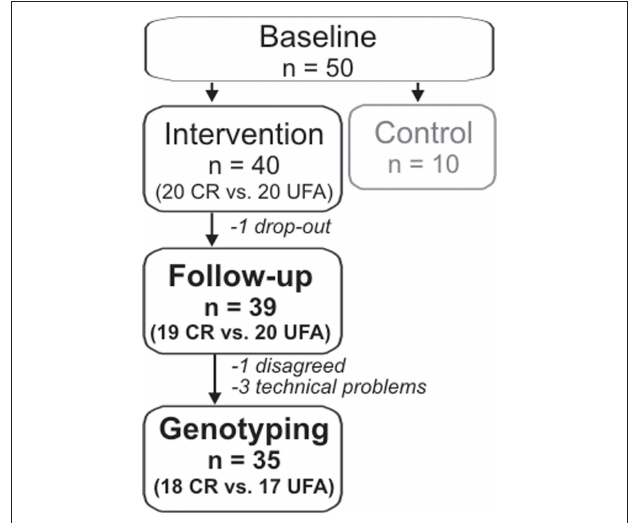
Figure 1 | Number of subjects included in the interventional study and genetic analyses. Subjects of the intervention groups underwent either Caloric restriction (CR) or enhancement of unsaturated fatty acids